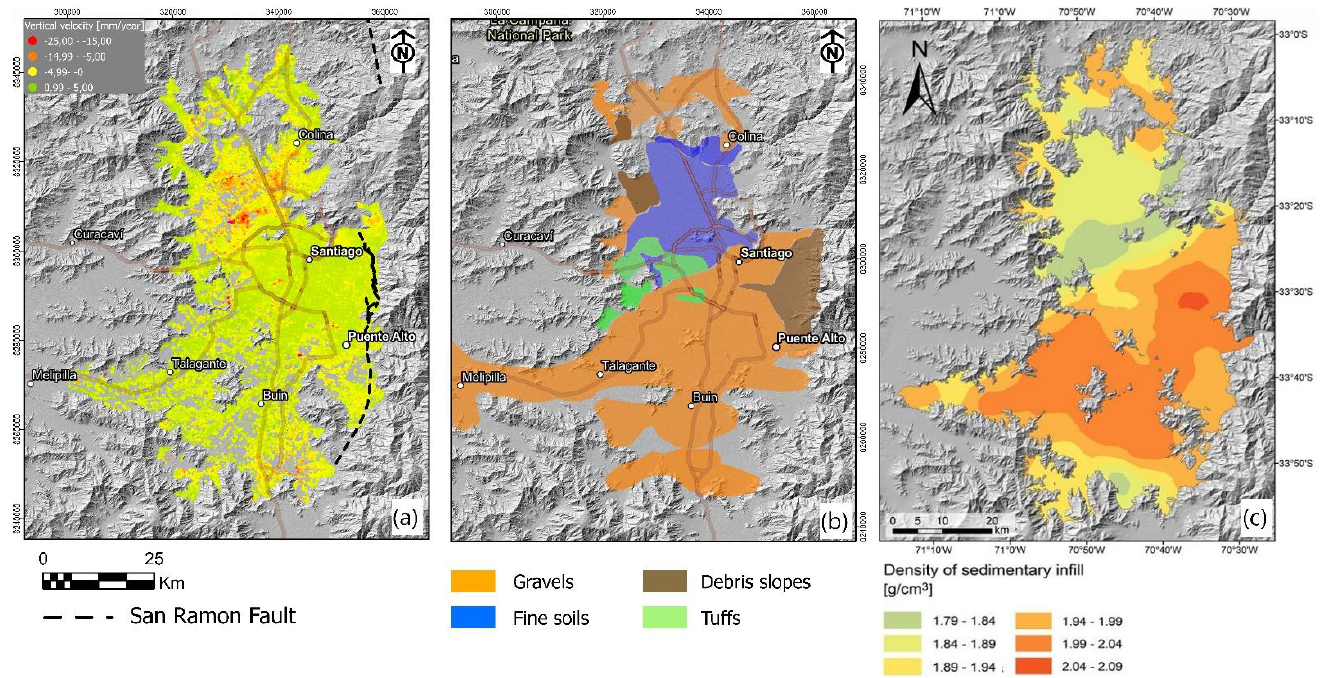
Figure 4. ( a ) Vertical displacement maps for study area, ( b ) Sediment cover map, and ( c ) Density of sedimentary infill map (modified from Yanez et al., [3]), with ALOS DEM 30 mts used as back-